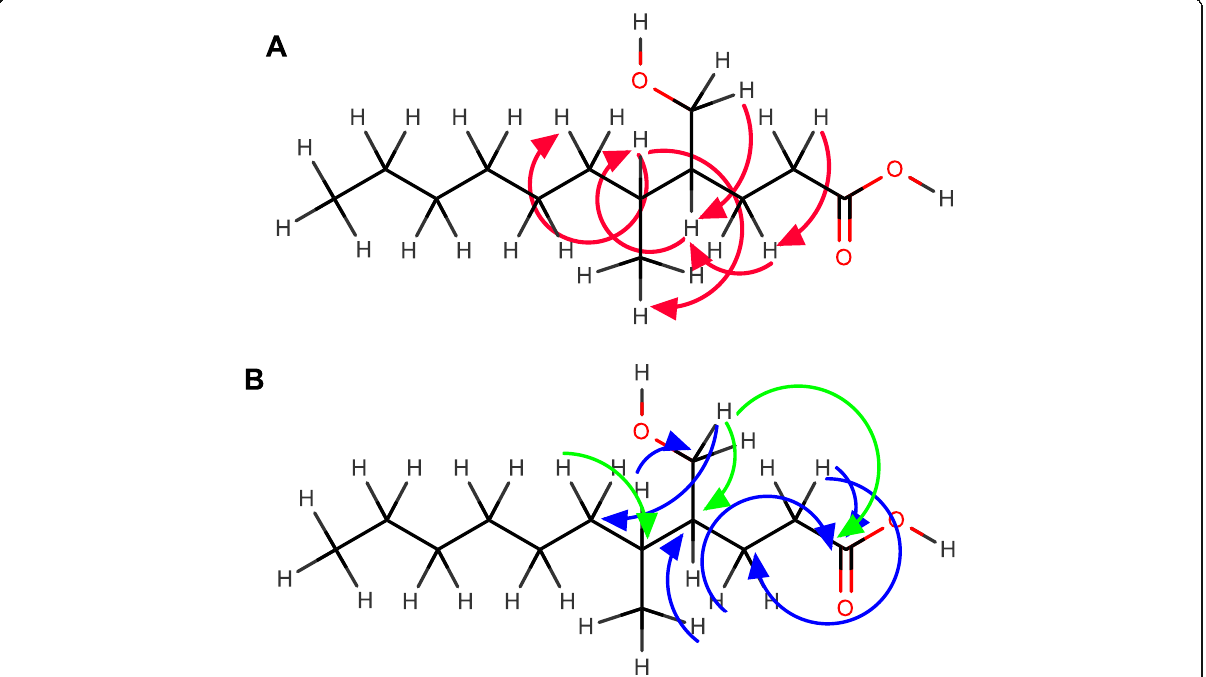
Fig. 4 Proton-proton and proton-carbon coupling in substructures of the major compound in fraction 8. a Proton- proton coupling as extracted from 1 H- 1 H COSY spectrum (Fig. S1). b Proton-carbon connectivity in substructure of compound 1 as extracted from 1 H- 13 C HMBC spectrum (Fig.